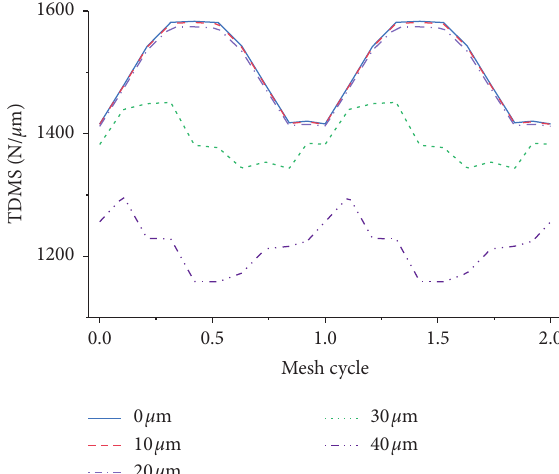
Figure 10: TDMS of the unmodified helical gear pairs under different load conditions.